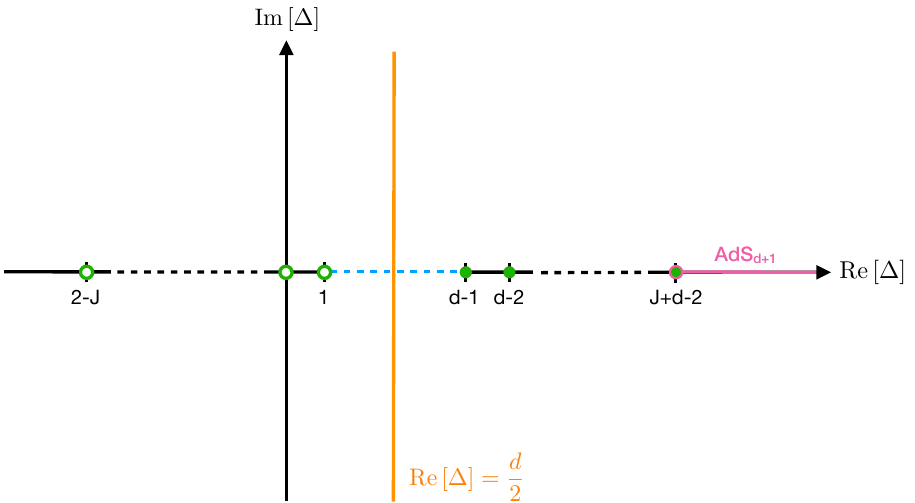
Figure 16. Unitary irreducible spin- J representations of SO ( d + 1 , 1) (green dots, blue line, yellow line) and SO ( d, 2) (pink line) in the complex ∆ plane. The yellow line corresponds to the Principal Series which has Re [∆] = d and the blue line the complementary series. The green dots denote 2 the discrete series representation, with the hollow green dots marking their shadows ( µ → − µ ). Spin- J unitary irreducible representations of SO ( d, 2) only overlap at the massless point, which is the rightmost green dot. Note the symmetry of this figure for unitary irreduble representations of SO ( d + 1 , 1) under µ → − µ (reflection in the yellow line). A similar figure with further details can be found in